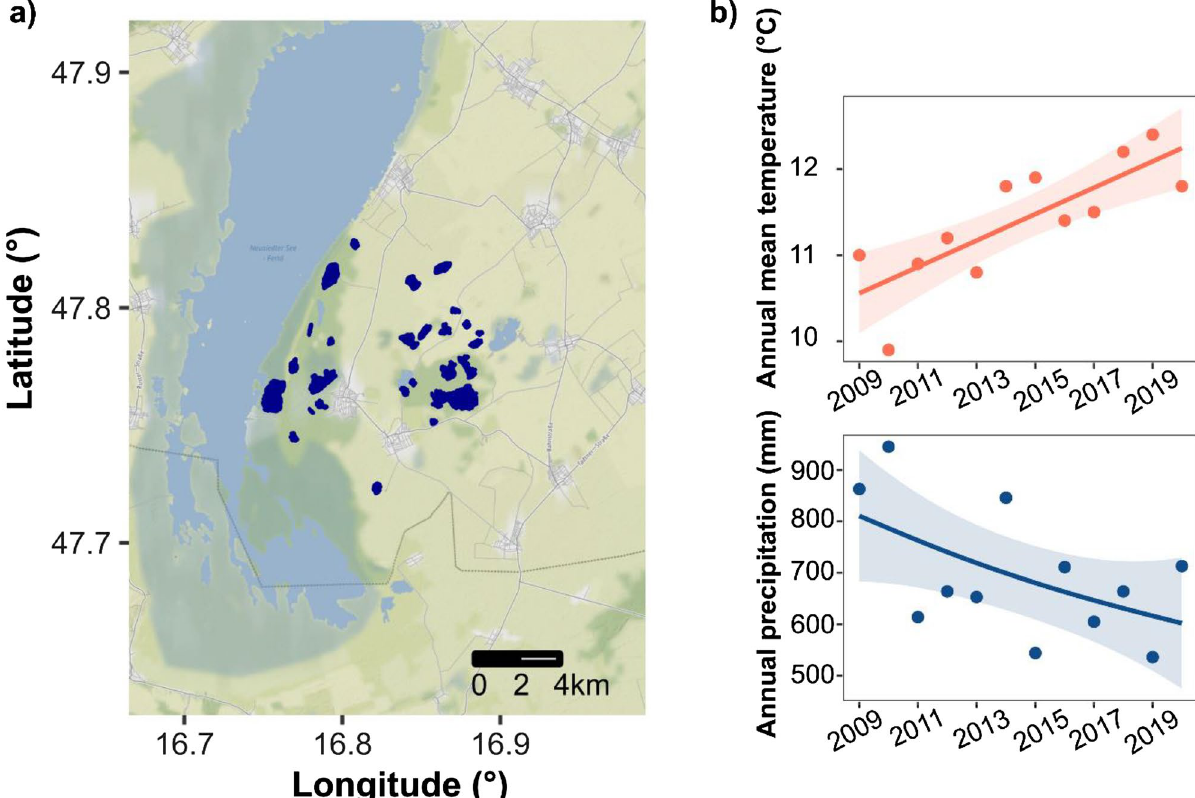
Figure 1. ( a ) Location of the sampled soda pans (dark blue) in the National Park Neusiedlersee-Seewinkel in eastern Austria (map was created with R v. 4.2.2 97 ). ( b ) Temporal trends in annual mean temperature and precipitation since 2009 based on meteorological data from the Seewinkel region (Station Eisenstadt; trendlines and confidence intervals are based on Generalized Additive Models, see also in Supplementary material Text